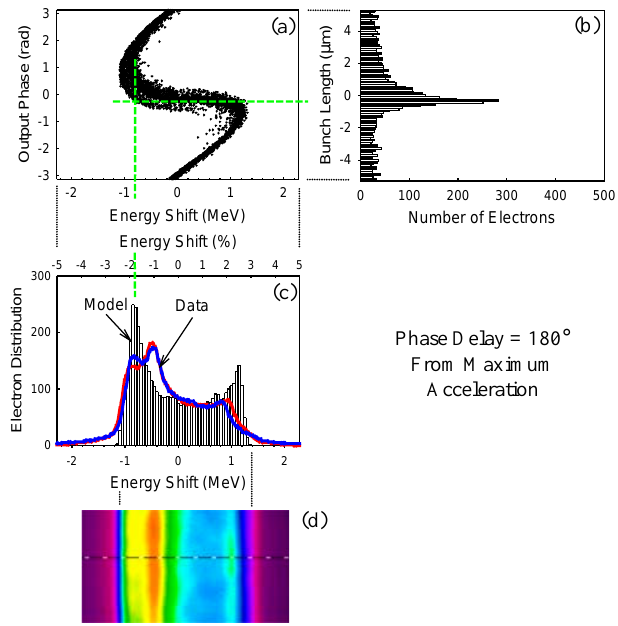
FIG. 5. (Color) Comparison of staging results with model for phase delay 180 ± from Fig. 3. (a) Model-predicted electron out- put phase versus electron energy, (b) model-predicted electron bunch length, and (c) electron energy spectrum. Two separate data profiles are plotted (red and blue curves). (d) Raw spec- trometer output for data plotted in (c).